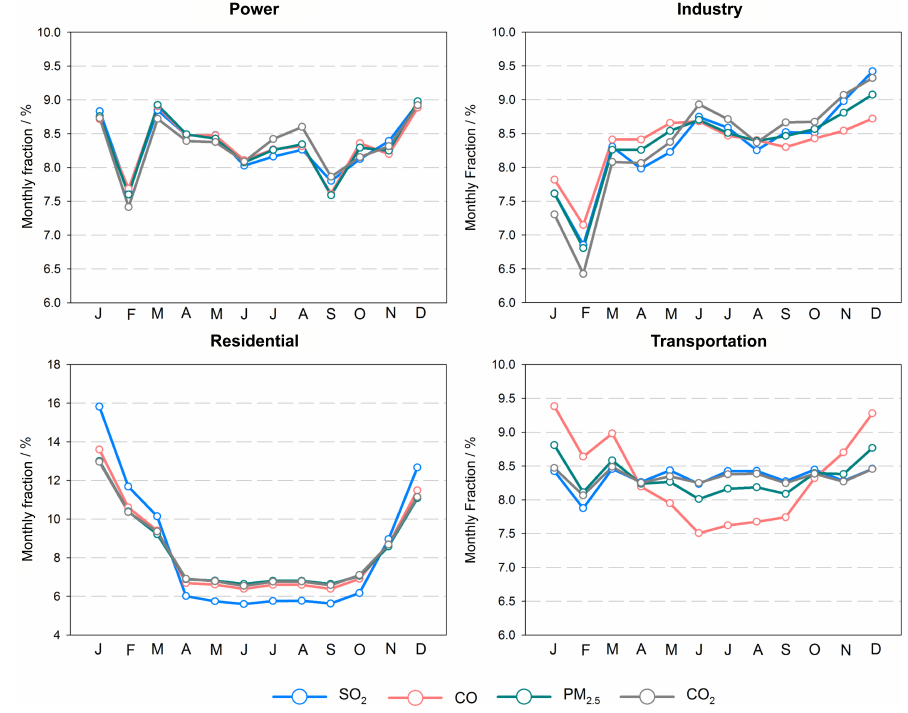
Figure 10. Monthly variations of Asian SO 2 , CO, PM 2 . 5 , and CO 2 emissions by sector for the year